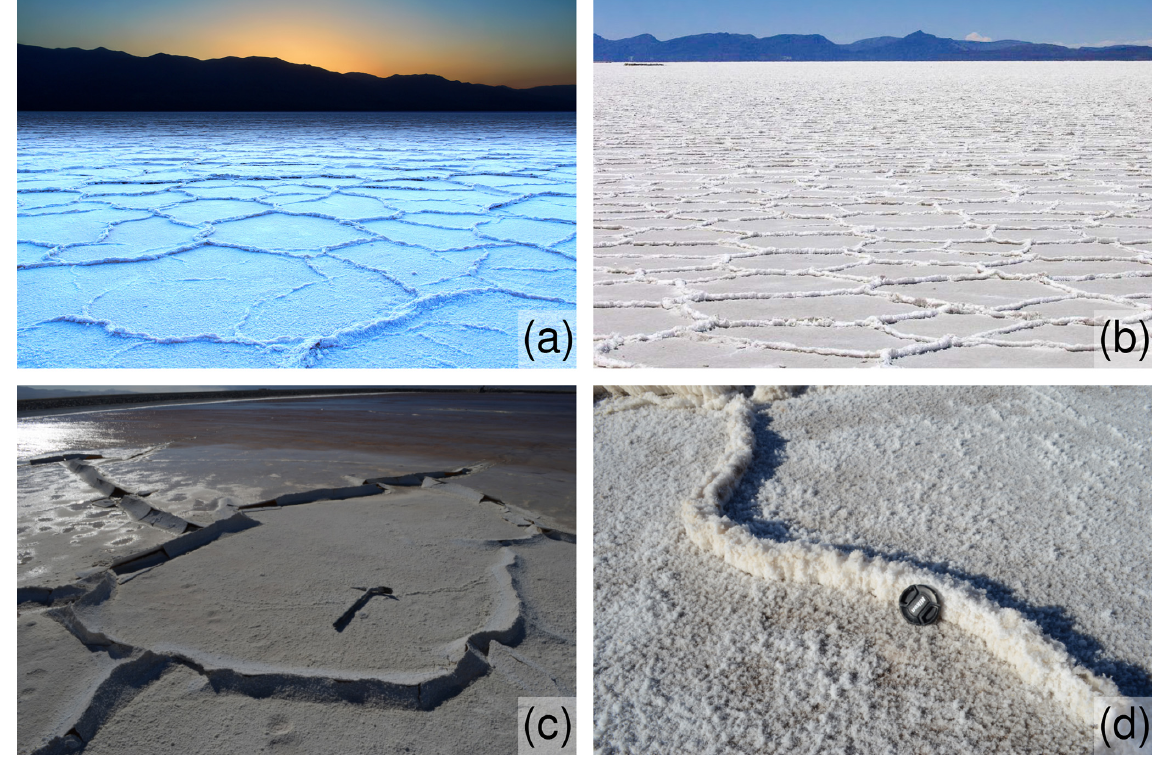
Figure 1. Polygonal ridge patterns in salt pans at (a) Badwater Basin, California (source: Photographersnature, 2019); (b) the Salar de Uyuni, Bolivia (source: Unel, 2019); and (c) Owens Lake, California, as well as (d) a close-up of a crust ridge at Badwater